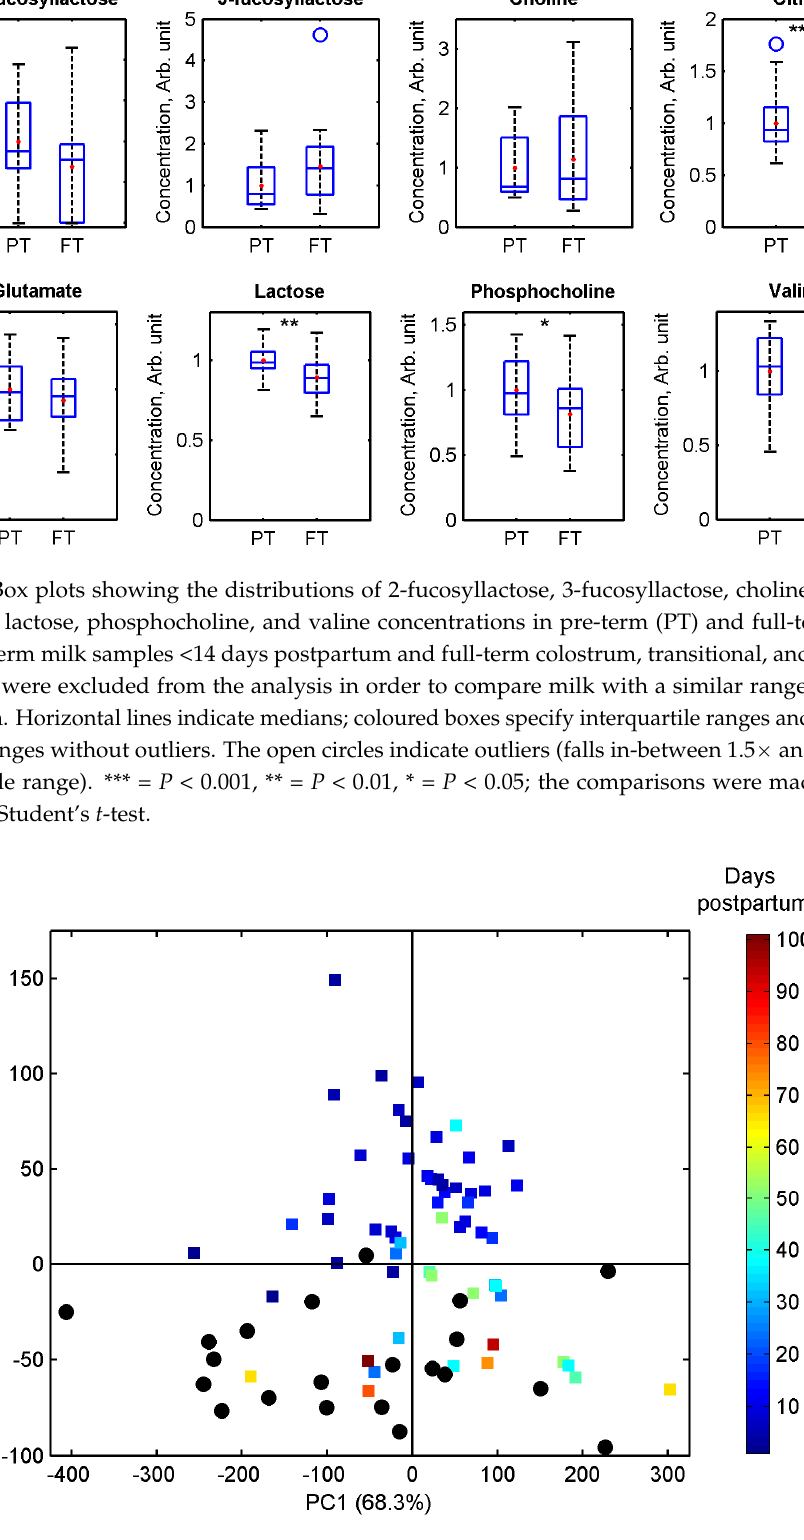
Figure 5. Principal component analysis scores plot of mature milk samples from pre ‐ term (squares, n = 58) and full-term (circles, n = 30) mothers. Pre-term milk samples are coloured according to n = 58) and full ‐ term (circles, n = 30) mothers. Pre ‐ term milk samples are coloured according to days days postpartum.